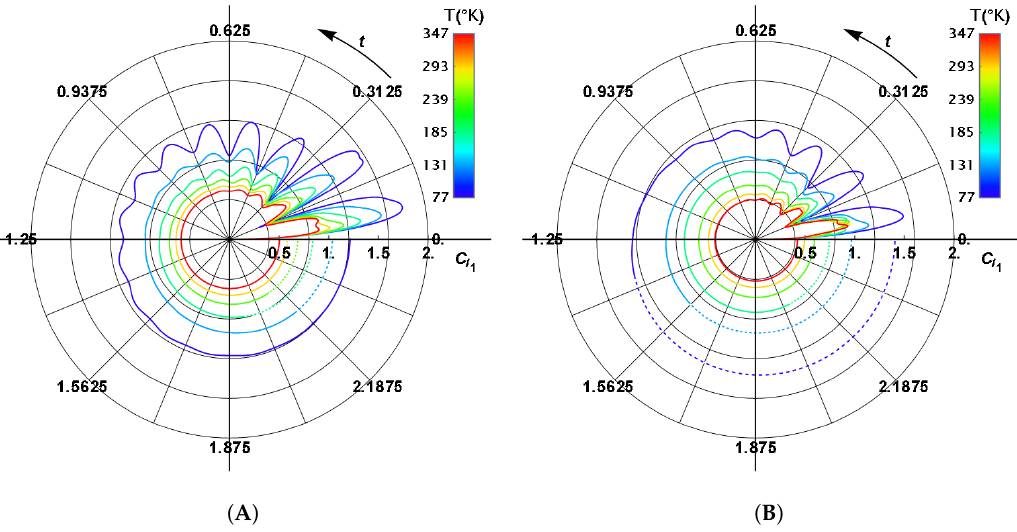
Figure 12. Evolution of coherence for the first 2.5ps for γ = 50cm − 1 as function of T in color, for ( A ) λ = 35cm − 1 , and ( B ) λ = 65cm − 1 showing the transition from concurrence between pair ( 1,2 ) —solid line—and ( 3,4 ) —dashed line—as the main provider of